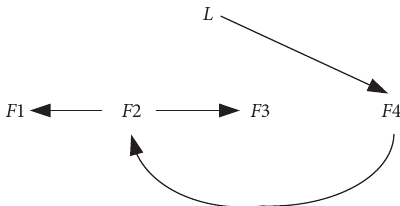
Figure 1: Network topology for a group of one leader (L) and four followers F1 to